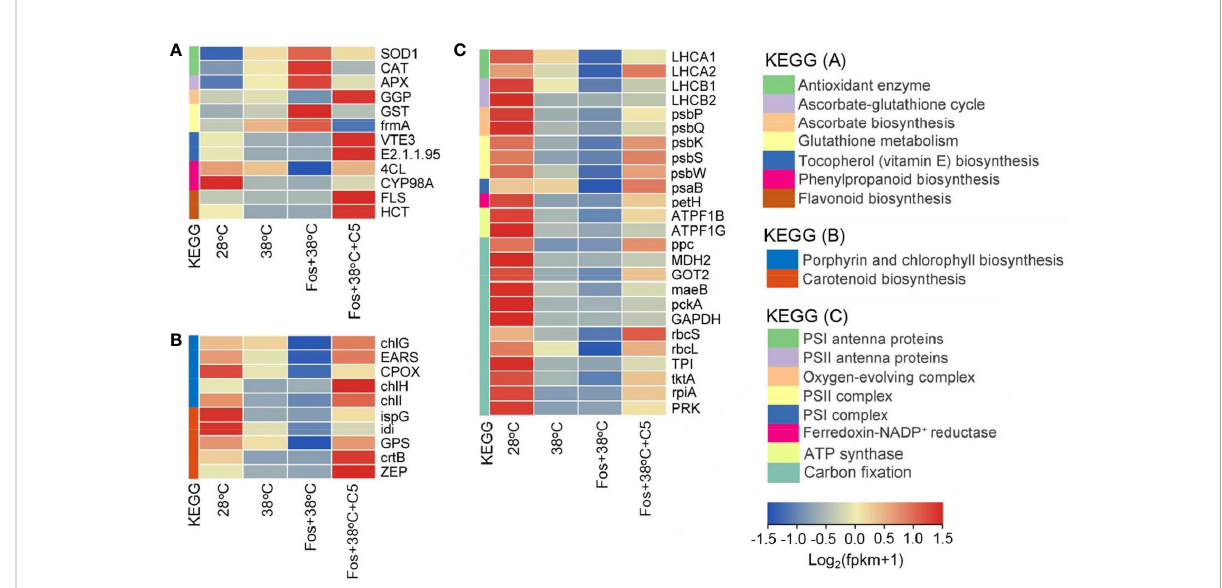
FIGURE 5 Effects of eucalyptol on gene expression in antioxidation (A) , photosynthetic pigment biosynthesis (B) , and photosynthetic abilities (C) in eucalyptol chemotype of C . camphora (EuL). 28°C, 38°C, and Fos+38°C: EuL was treated with normal temperature, high temperature, and high temperature with fosmidomycin (Fos) pretreatment, respectively. Fos+38°C+E5: EuL blocked monoterpene synthesis with Fos was fumigated with 5 m M eucalyptol at 38°C. KEGG: Kyoto encyclopedia of genes and genomes pathways. The heatmap was drawn using the FPKM (fragments per kilobase per million mapped reads) by using the software R packages pheatmap 1.0.12. Means (n = 3) are